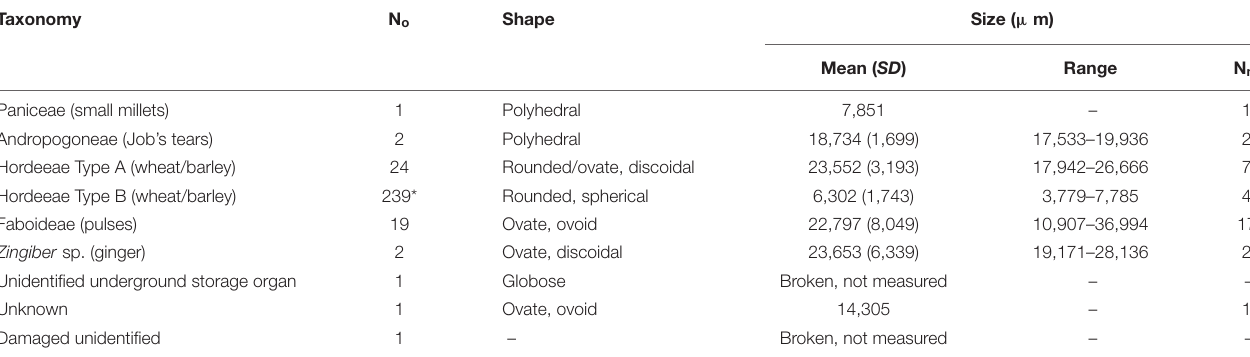
FIGURE 3 | Starch grains observed in samples from pottery vessels from Datrana, Loteshwar and Shikarpur: (A) Paniceae (small millet) grain form sample DTR120; (B) Andropogoneae (Job’s tears) grain from sample 031109/11; (C) cluster of Hordeeae (wheat/barley) grains from sample DTR116; (D) Faboideae (pulses) grains from sample 071109/20; (E) Zingiber sp. (ginger) grain from sample 050212/8; and (F) undetermined underground storage organ from sample 250112/8. Scale bar: 20 µ m (for comparative reference material, see Supplementary Figure 1 ). TABLE 3 | Shape and size of the starch grain morphotypes found in pottery vessels from Datrana, Loteshwar and